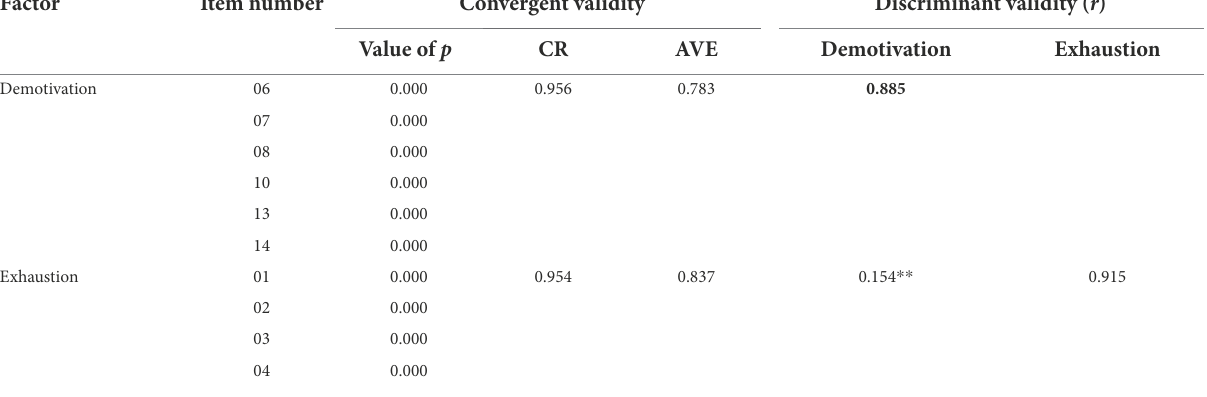
TABLE 3 Convergent validity and discriminant validity of each subscale.